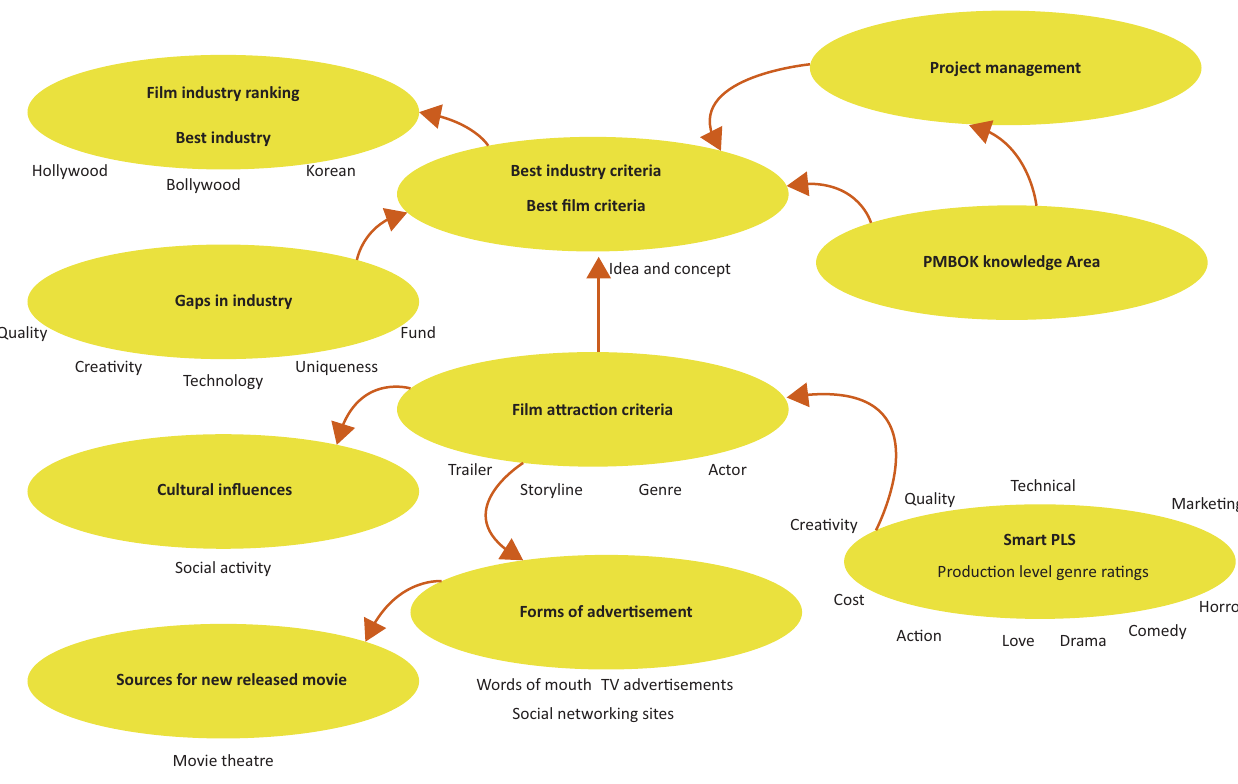
FIGURE 5: Relational summary of survey